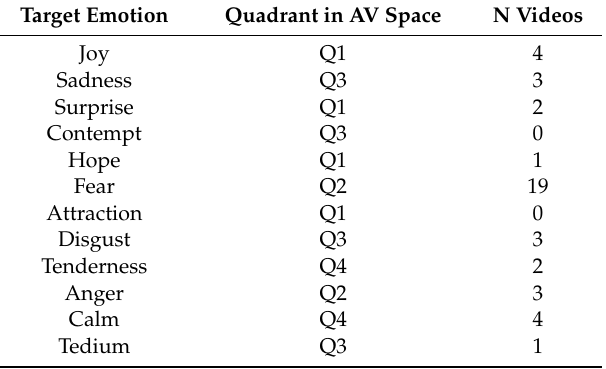
Table 3. Distribution of videoclips selected in UC3M4Safety Database according to AV